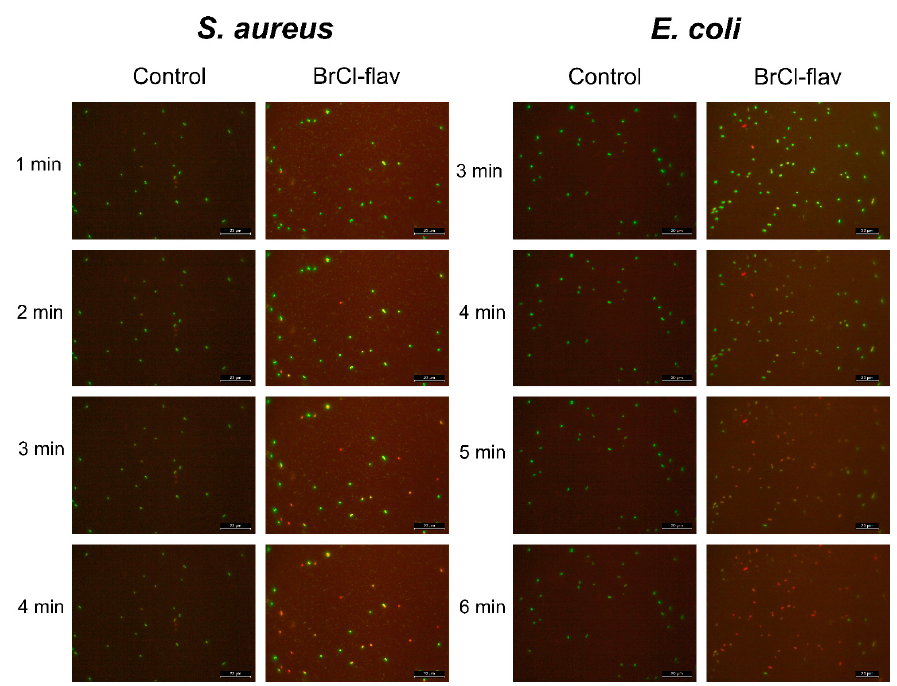
Figure 6. Fluorescent images of a time course experiment illustrating the S. aureus medbio1-2012 and E. coli medbio4-2013 cell membrane disruption effects due to BrCl-flav exposure, visualized by the influx of the fluorescent nuclear stain propidium iodide. The cells were stained using a Live/Dead BacLight Bacterial Viability Kit (Invitrogen, Waltham, MA, USA). The captured images are representative of a typical result.